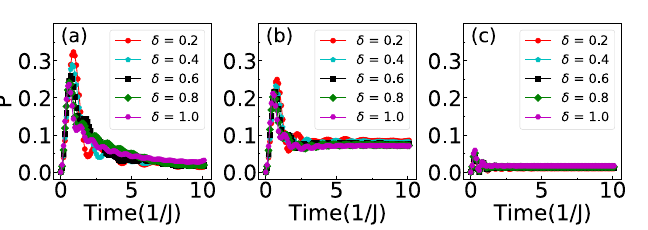
Figure 8. Time evolution of P for different values of δ and ( a ) for U = 0 , ( b ) for U = 2 and ( c ) for U = 10 corresponding to the initial state given in Eq.